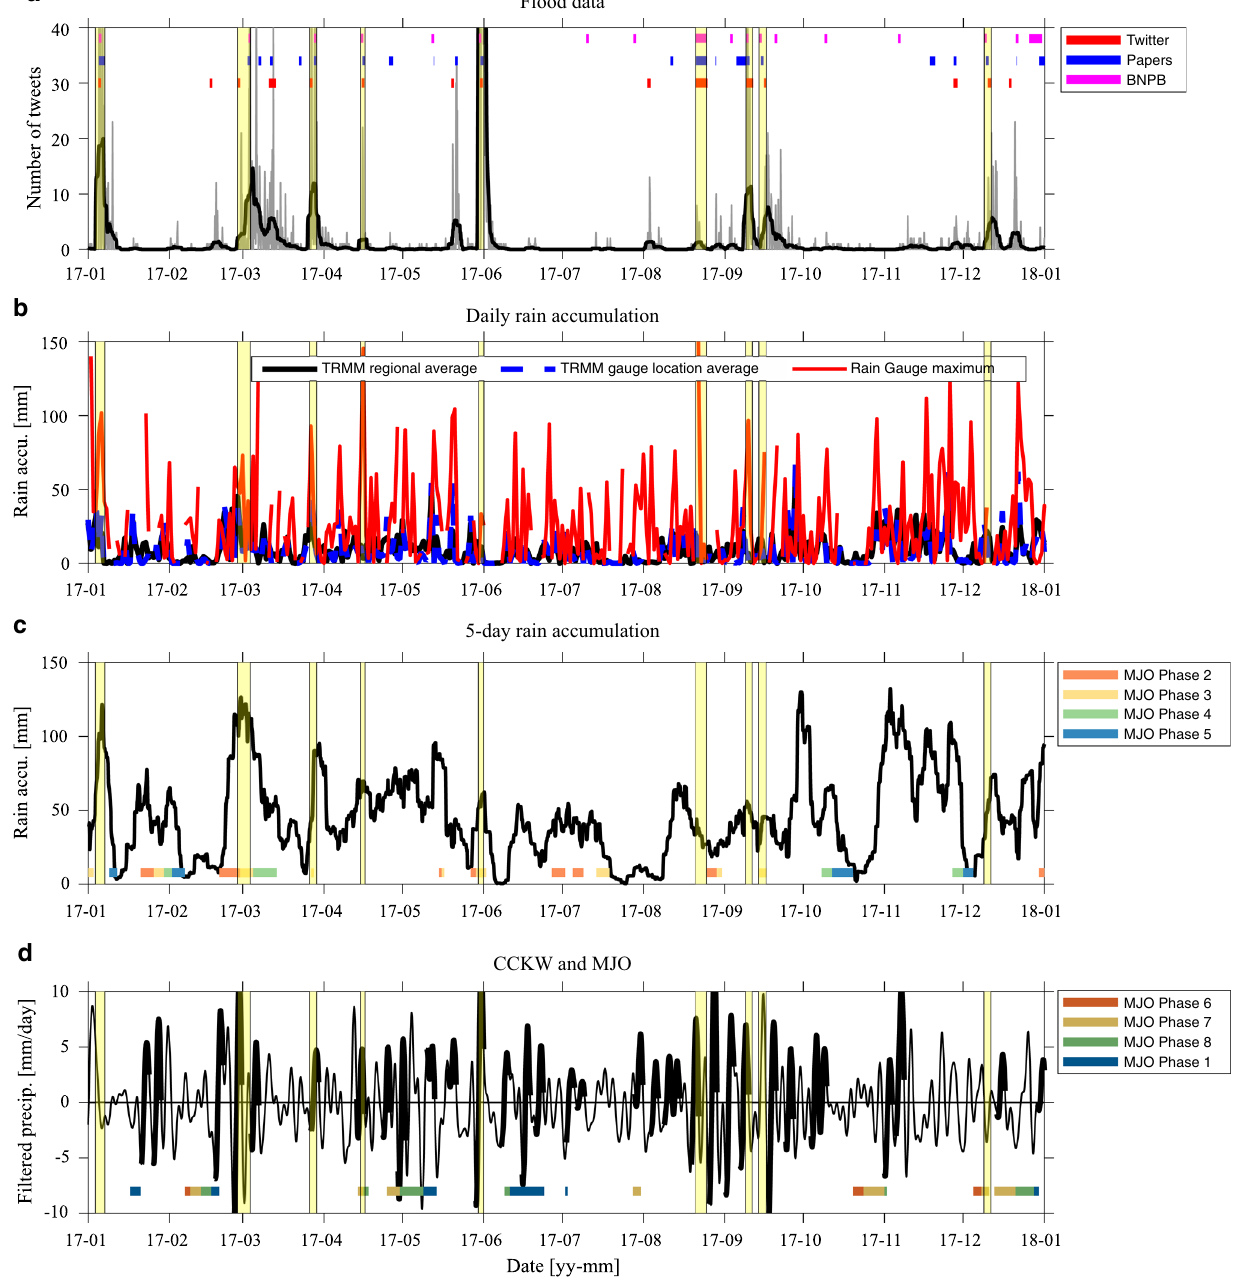
Fig. 2 Floods and meteorological conditions in West Sumatra in 2017. Time series of fl ood and meteorological conditions during 2017 in West Sumatra. a 3- hourly Twitter data (gray line) and 3-day running average of Twitter data (black line); colored bars indicate fl oods identi fi ed in Twitter (red), paper (blue) and Indonesian National Board for Disaster Management (BNPB) (magenta) databases in 2017, ( b ) daily precipitation accumulation [mm] averaged over West Sumatra region from TRMM (black line), averaged over rain-gauge locations only from TRMM (blue dashed line) and maximum value of the three rain-gauges (red line), ( c ) 5-day precipitation accumulation [mm] averaged over the West Sumatra region in 2017 and Madden Julian Oscillation (MJO) phase Real-time Multivariate Madden Julian Oscilation index (RMM) phases 2 – 5 for RMM amplitude above 1 only, see legend), ( d ) convectively coupled Kelvin wave (CCKW) precipitation rate anomaly [mm/day] averaged over the the West Sumatra region and the MJO phase (RMM phases 6 – 1 for RMM amplitude above 1 only, see legend). Thick black lines in d indicate the robust CCKWs de fi ned as the waves with a well de fi ned trajectory 20 at least between longitudes 80E and 110E. The yellow shading in all panels indicates major fl ooding periods for which identi fi cation from Twitter, Papers and BNPB